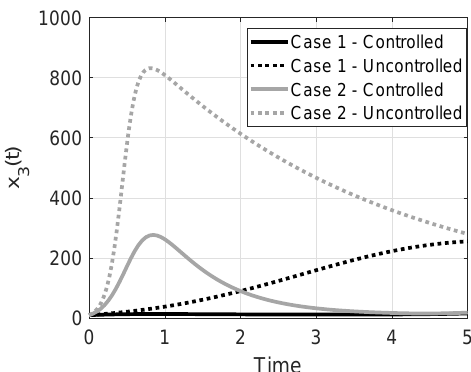
Figure 7. Evolution of the number of x 3 ( t ) subjects in Case 1 (black line) and Case 2 (grey line) with (continuous line) and without control (dotted